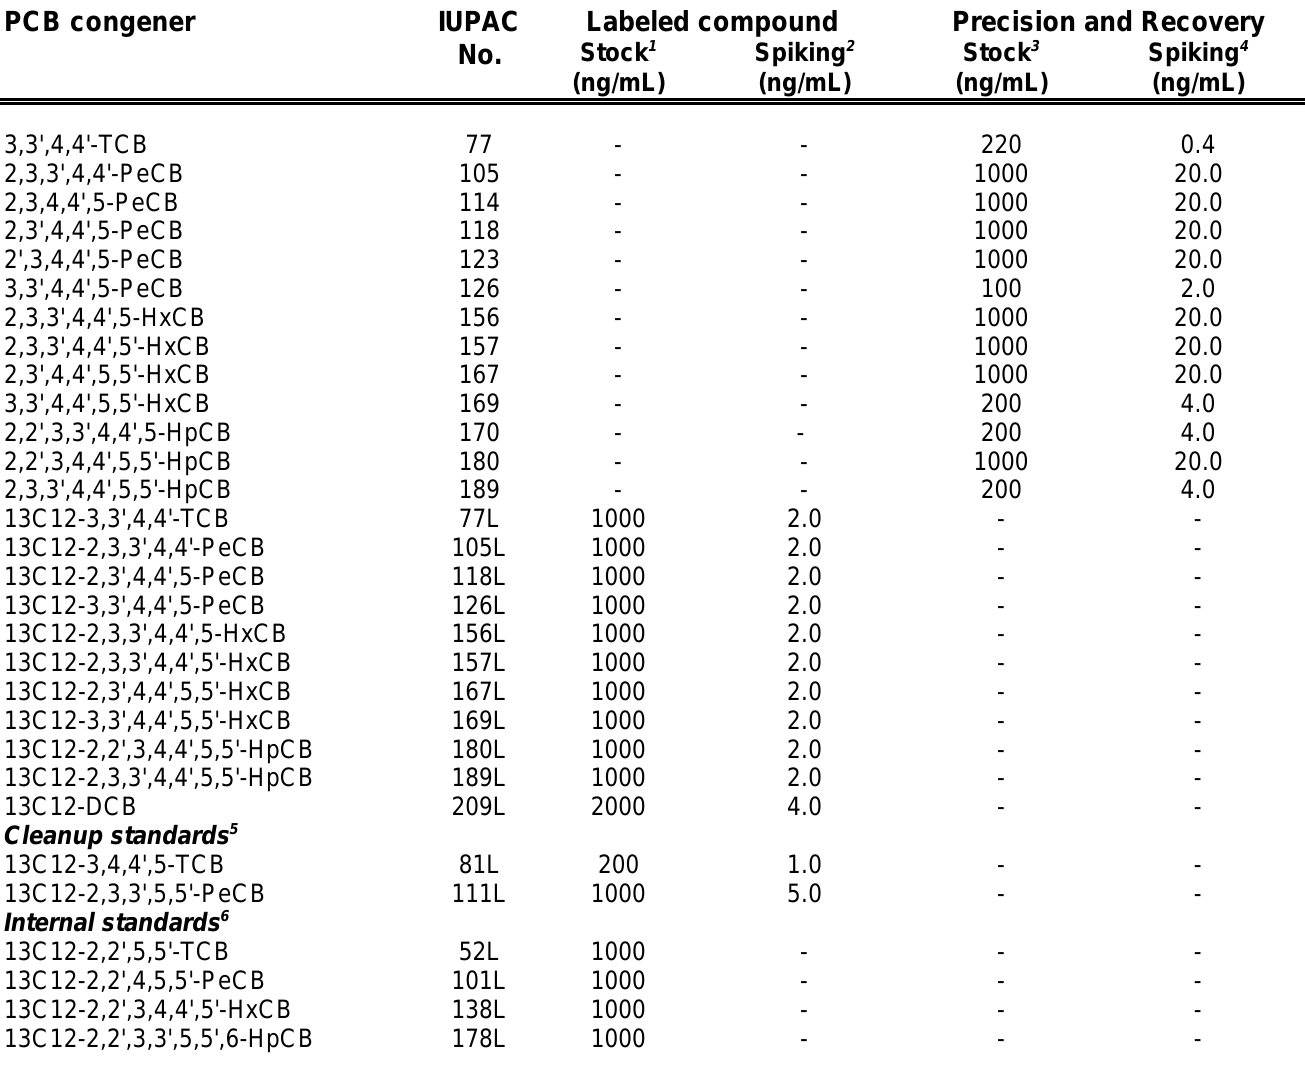
Table 3. Concentrations of Stock and Spiking Solutions Containing the Native PCBs and Labeled Compounds PCB